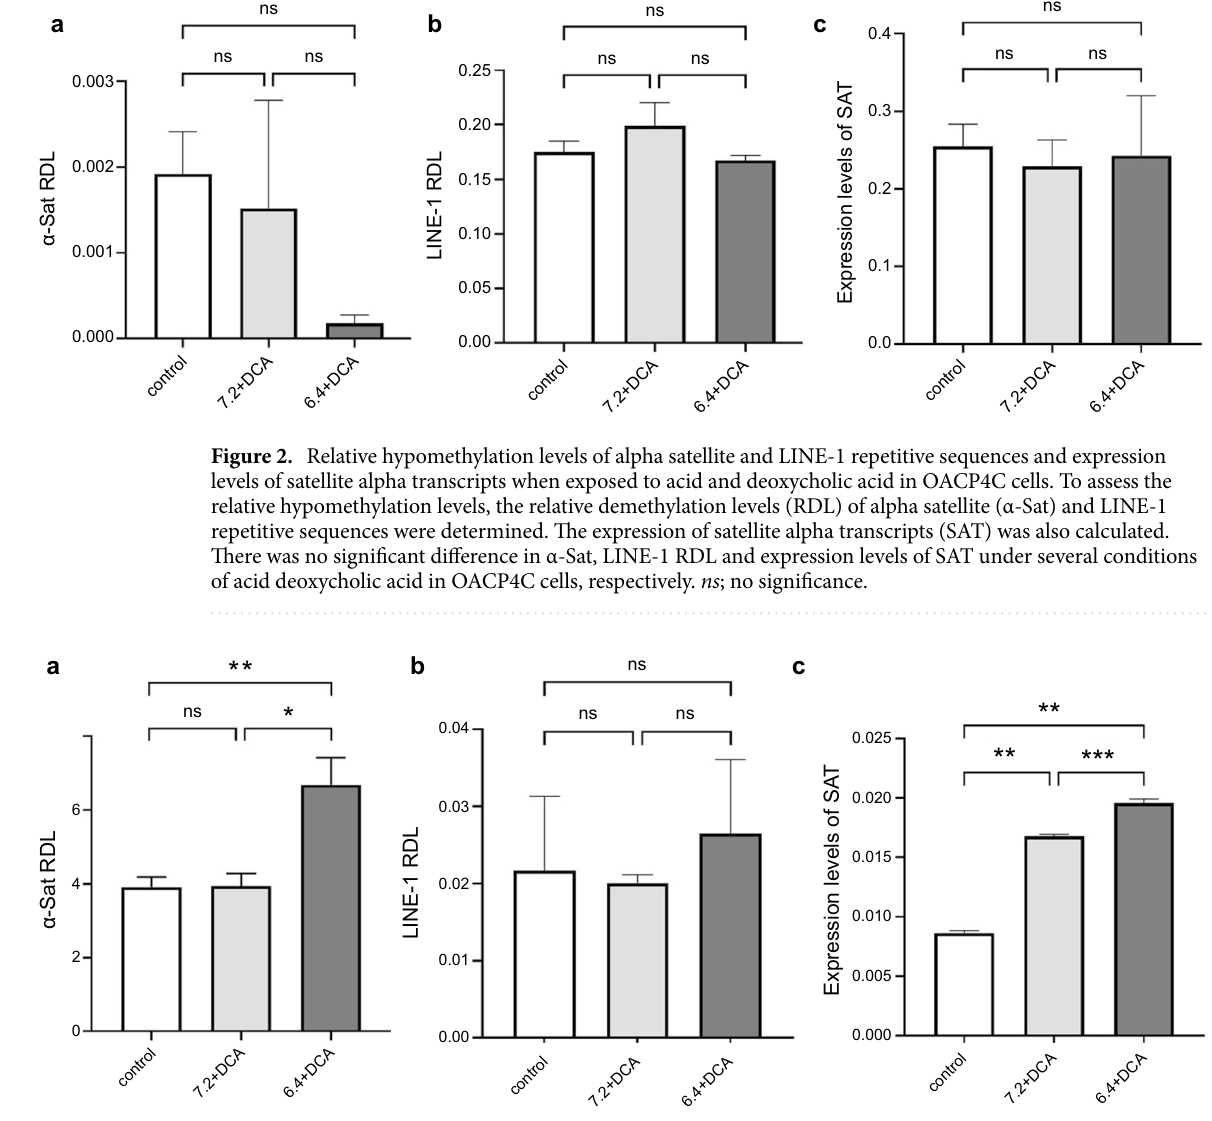
Figure 3. Relative hypomethylation levels of alpha satellite and LINE-1 repetitive sequences and expression levels of satellite alpha transcripts in response to acid exposure and deoxycholic acid in CP-A cells. The levels of alpha satellite (α-Sat) were substantially increased in response to acid exposure in CP-A ( a ) although there were no changes in those of LINE-1 RDL ( b ). The expression levels of SAT were significantly elevated based on the extent of DNA hypomethylation in response to acid exposure ( c ). ns ; no significance *p = 0.0001, **p < 0.0001, ***p =